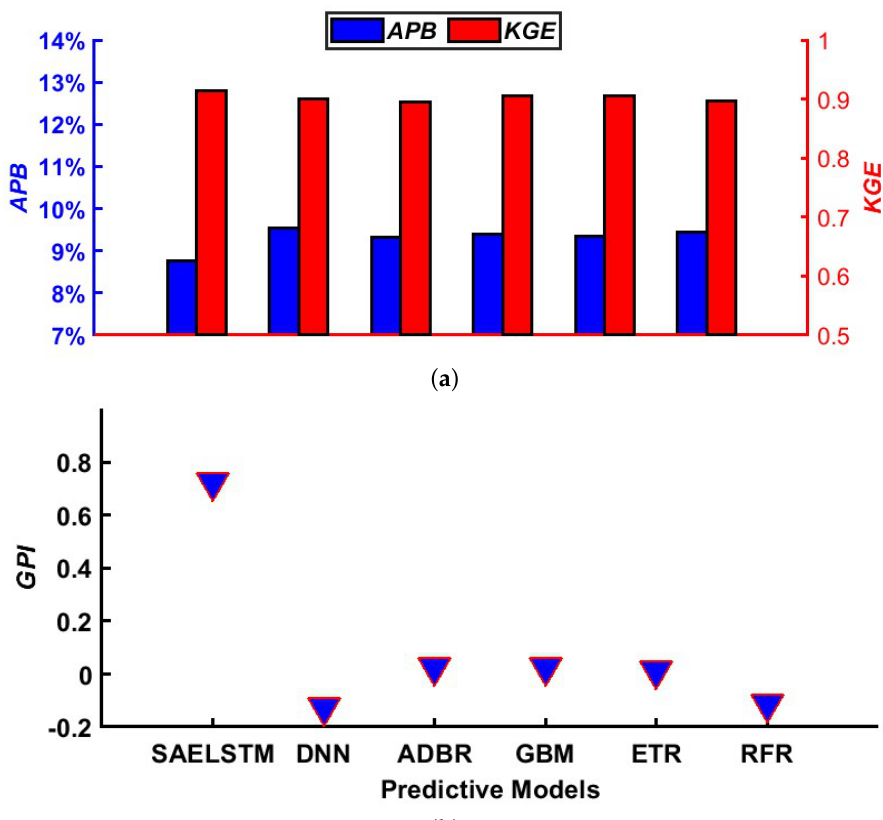
Figure 10. ( a, top ) Bar plots of prediction error chart showing a comparison of the proposed SAELSTM model using APB, percentage, and KGE in the testing phase. ( b, bottom ) Global performance indicator (GPI) of CLC model compared with other counterpart models. (Note: Names for each model are provided in Tables 3 and A1 in Appendix